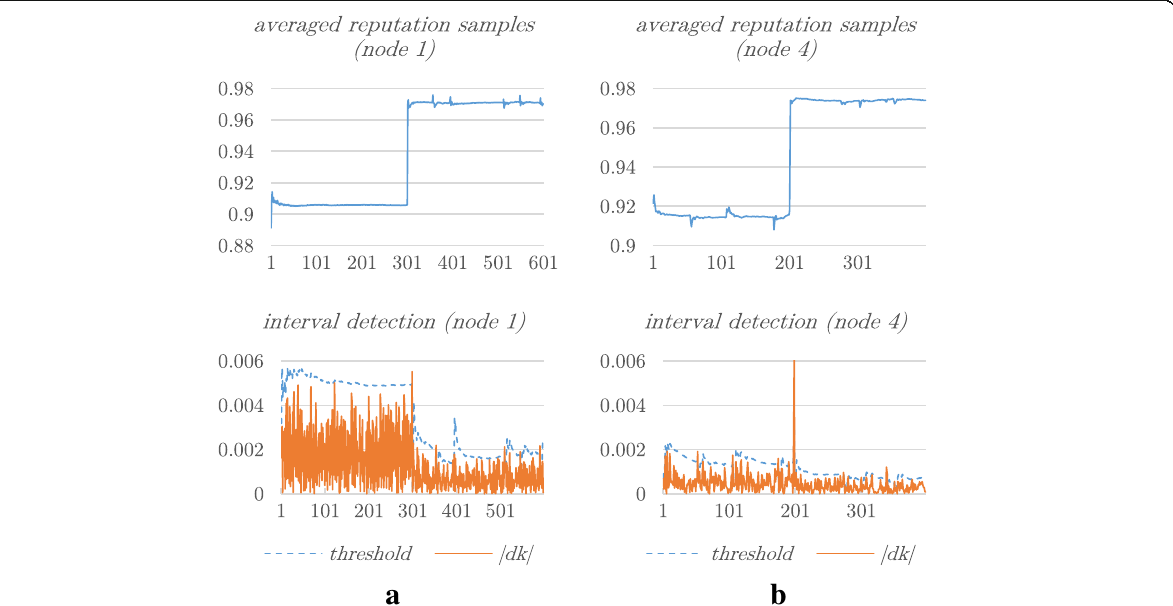
Fig. 5 Average value of the samples (figures at the top) and interval detection (figures below) when β =0.1 and F =2: a for node 1 and b for node